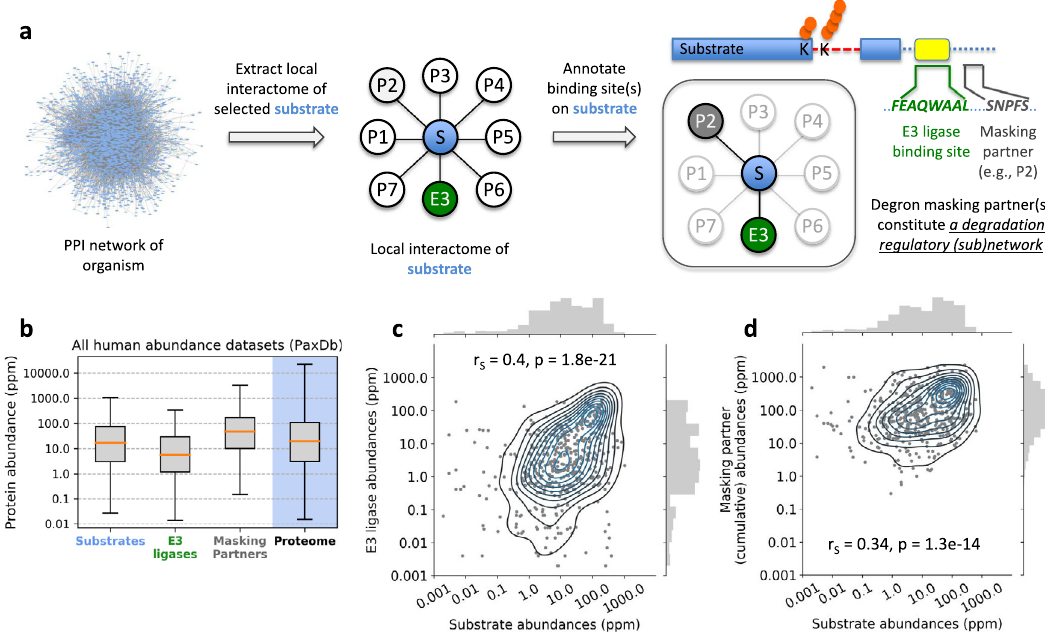
Fig. 4 Substrate degradation regulatory modules and their analysis based on protein abundances. a After identifying interacting proteins for a selected substrate (its “ local interactome ” ), available binding site/motif information is used to identify partners whose binding sites overlap substrate degrons. This subset of partners constitutes a degradation regulatory module (or subnetwork) for the substrate of interest. b Based on this concept, we identi fi ed the protein components that comprised the primary degron regulatory subnetworks for selected human substrates (Table 1). Relative protein abundances were compared after grouping into the three relevant categories: substrates, E3 ligases (including E3 adaptor subunits), and the degron masking alternate partners (APs). The total number of abundance data points for each of these groups: substrates ( N = 1069), E3s (472) and APs (3838). For comparison, the abundance distribution for the entire human proteome is also shown. Outliers not shown in the boxplots. c Scatter plot of substrate and corresponding E3 ligase pairwise abundances across all 170 PaxDb datasets. Abundances were taken from each individual PaxDb dataset, whenever data for both proteins of a pair (i.e., substrate, E3) were available. d Scatter plot between the abundance value of each substrate and summed abundances of all its corresponding masking partners (APs), from each PaxDb dataset, wherever data for all the proteins of each group (i.e., substrate and its corresponding APs) were available. Spearman ’ s correlation coef fi cients (r S ) and corresponding p -values are shown on the fi